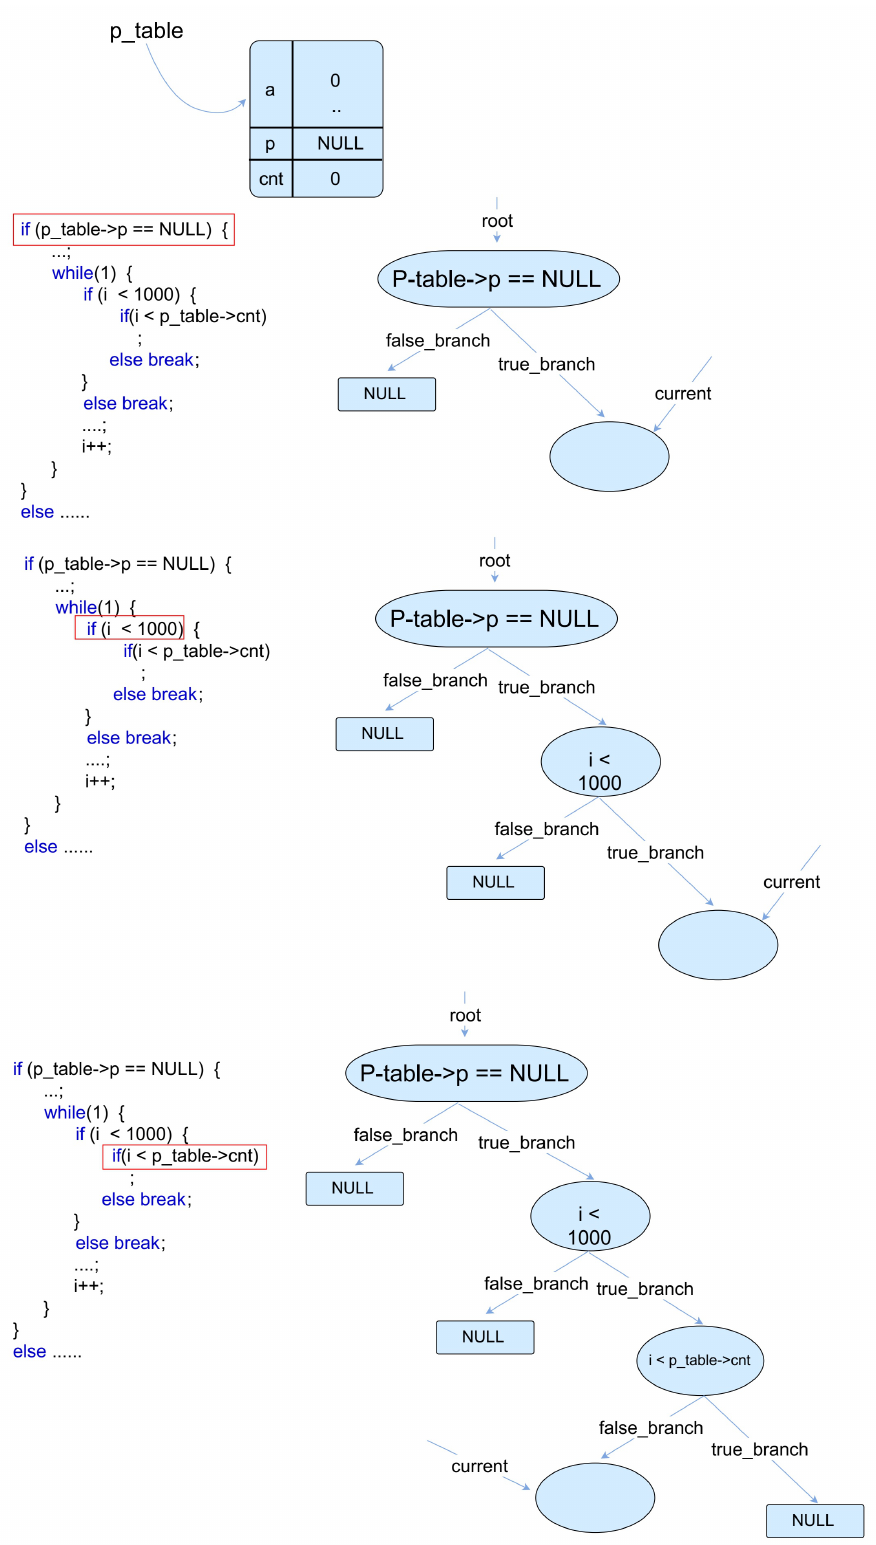
Figure 5. Path execution